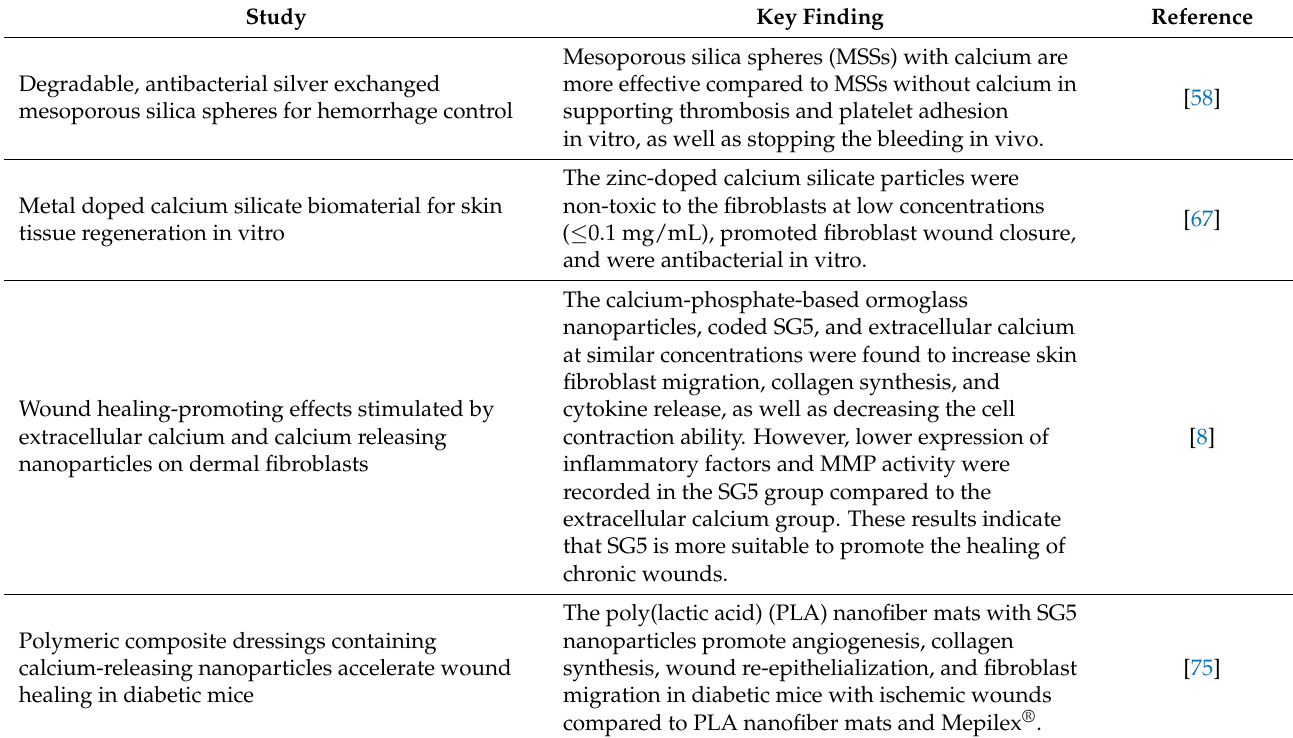
Table 3. Studies using calcium-releasing